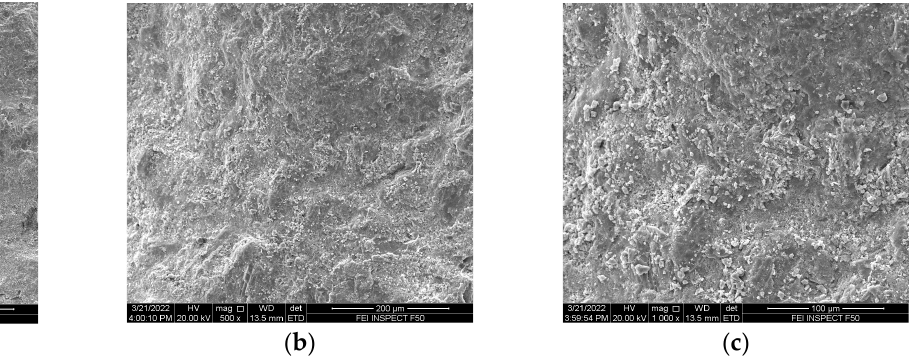
Figure 8. SEM surface morphology of basalt aggregates: ( a ) ×200 Magnification; ( b ) ×500 Magnifica- tion; ( c ) ×1000 Magnification.